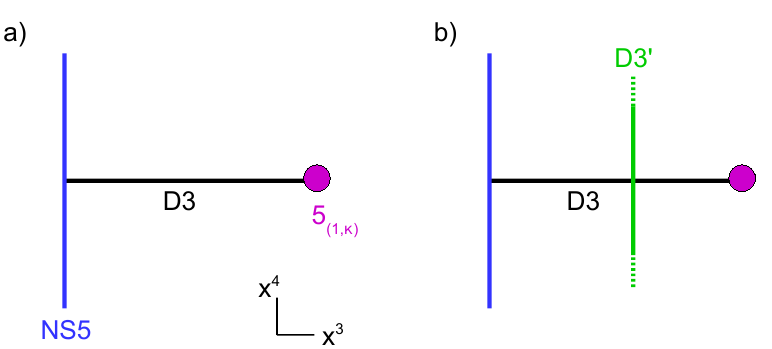
Figure 4 . (a) Brane con(cid:12)guration realizing the U(1) (cid:20) theory, in the ( x 3 ; x 4 ) plane. (b) The addition of a D3 (cid:13) (= D3’) brane inserts the chiral operator ’ vanishing in the